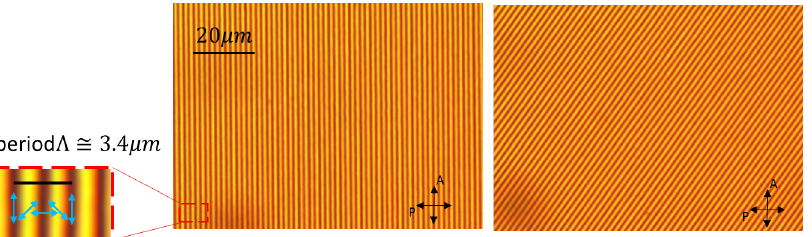
Figure 5. Polarization microscopy images of the LC phase grating, with the grating parallel to one of the polarizers (left) or rotated over 45 degrees (right). The inset at the left illustrates the grating